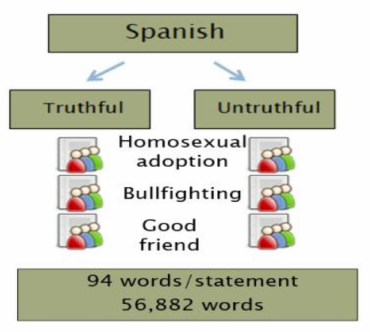
Figure 2. Structure of the